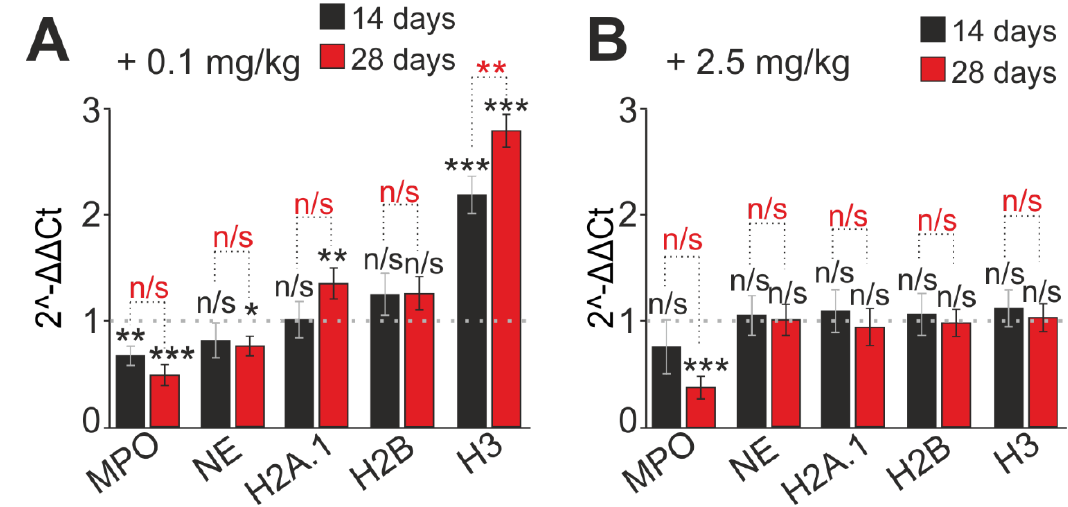
Figure 7. Effect of SeNPs applied in vivo on expression of genes involved in NETs formation. Respective mRNA expression genes encoding H2A.1, H2B, H3, neutrophil elastase (NE), and myeloperoxidase (MPO) in neutrophils 14 (black bars) and 28 (red bars) days after 0.1 mg Se/kg ( A ) and 2.5 mg Se/kg ( B ) SeNPs were injected daily. Dashed line — level of gene expression in controls (mice with administration of saline). GAPDH was used as housekeeping gene. Data are shown as mean ± SEM of five independent experiments. Statistical analysis of experimental groups versus control was performed with paired t -test and marked with black asterisks. Significance between experimental groups marked with red asterisks: *** p < 0.001, ** p < 0.01, and * p < 0.05; n/s — no significance.